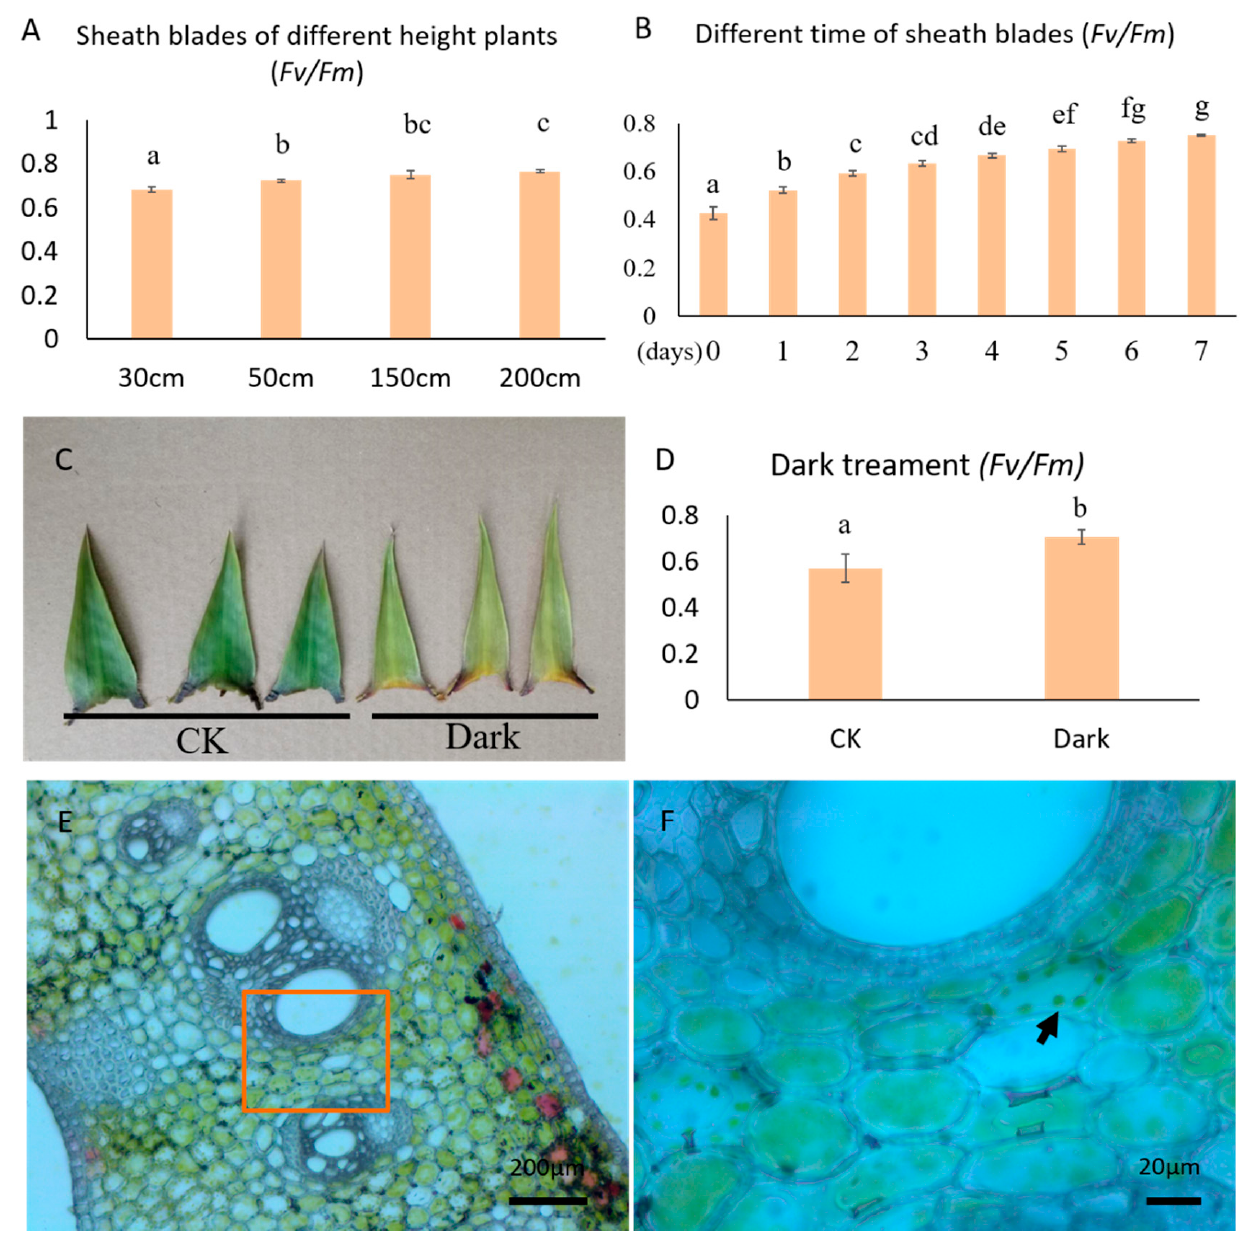
Figure 3. Changes in fluorescence parameters. ( A ) Fv/Fm values for sheath blades located in the middle of bamboo shoots at different heights. ( B ) Fv/Fm value of newly expanded sheath blades measured for 8 consecutive days. ( C , D ) Fv/Fm value of shaded bamboo sheaths. ‘CK’ indicates that the culm sheaths were not shaded, and ‘Dark’ indicates that the culm sheaths were shaded with black cloth. ( E ) Chloroplast distribution in sheath blades. ( F ) Enlargement of the red rectangle in ( E ). The black arrows indicate chloroplasts. Different letters indicate significant differences between the average values of the column (± SE, n = 6), p < 0.05.